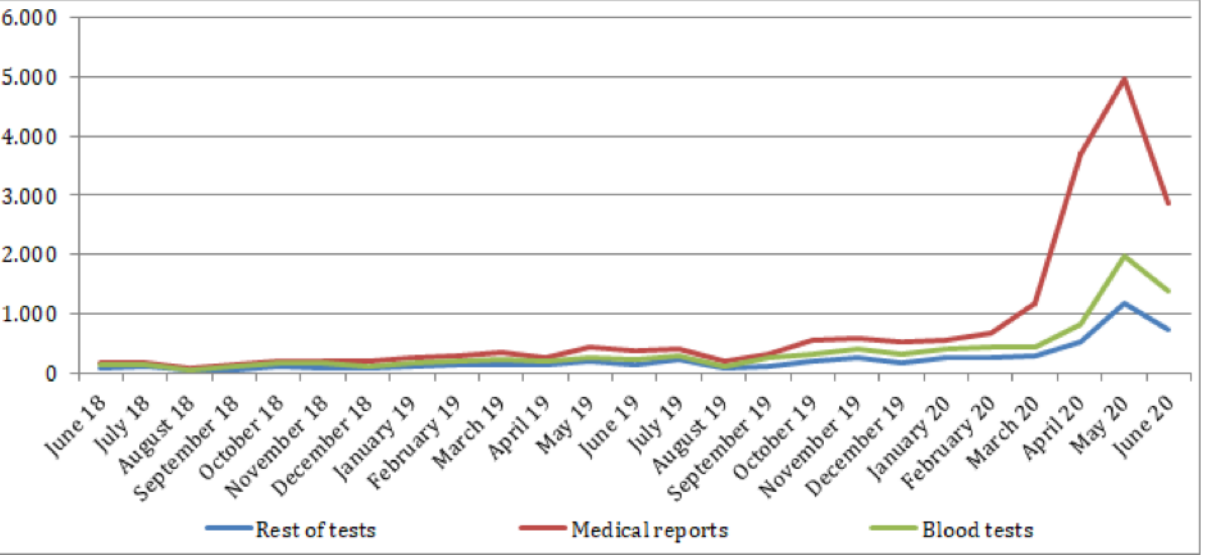
Figure 2. Evolution of the number of documents attached to eConsulta messages, classified by